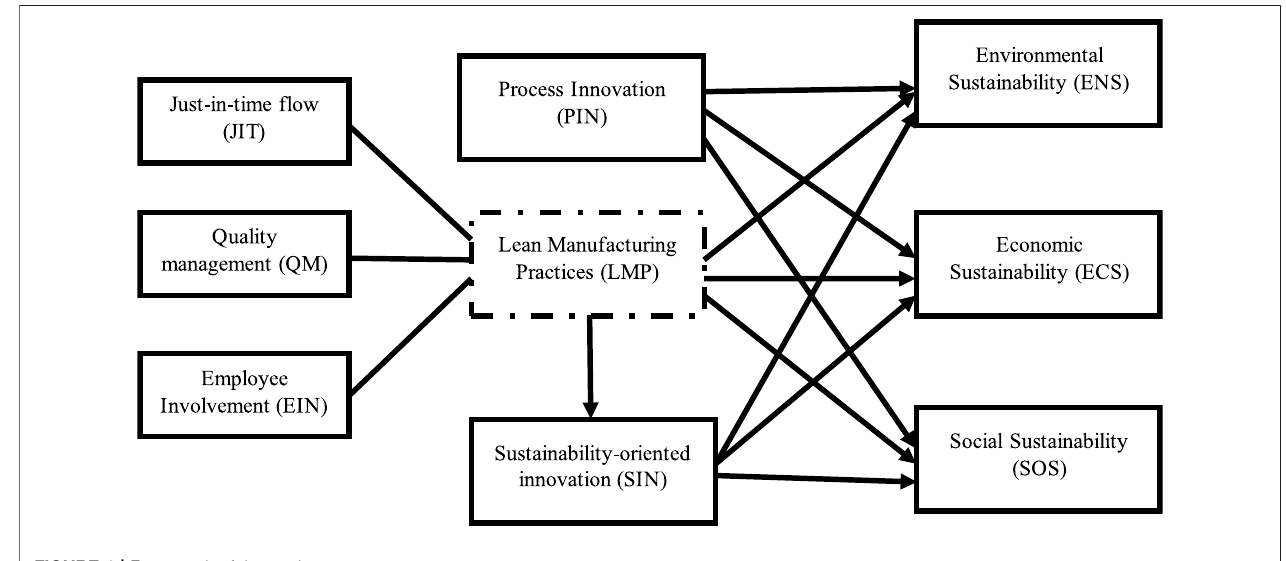
FIGURE 1 | Framework of the